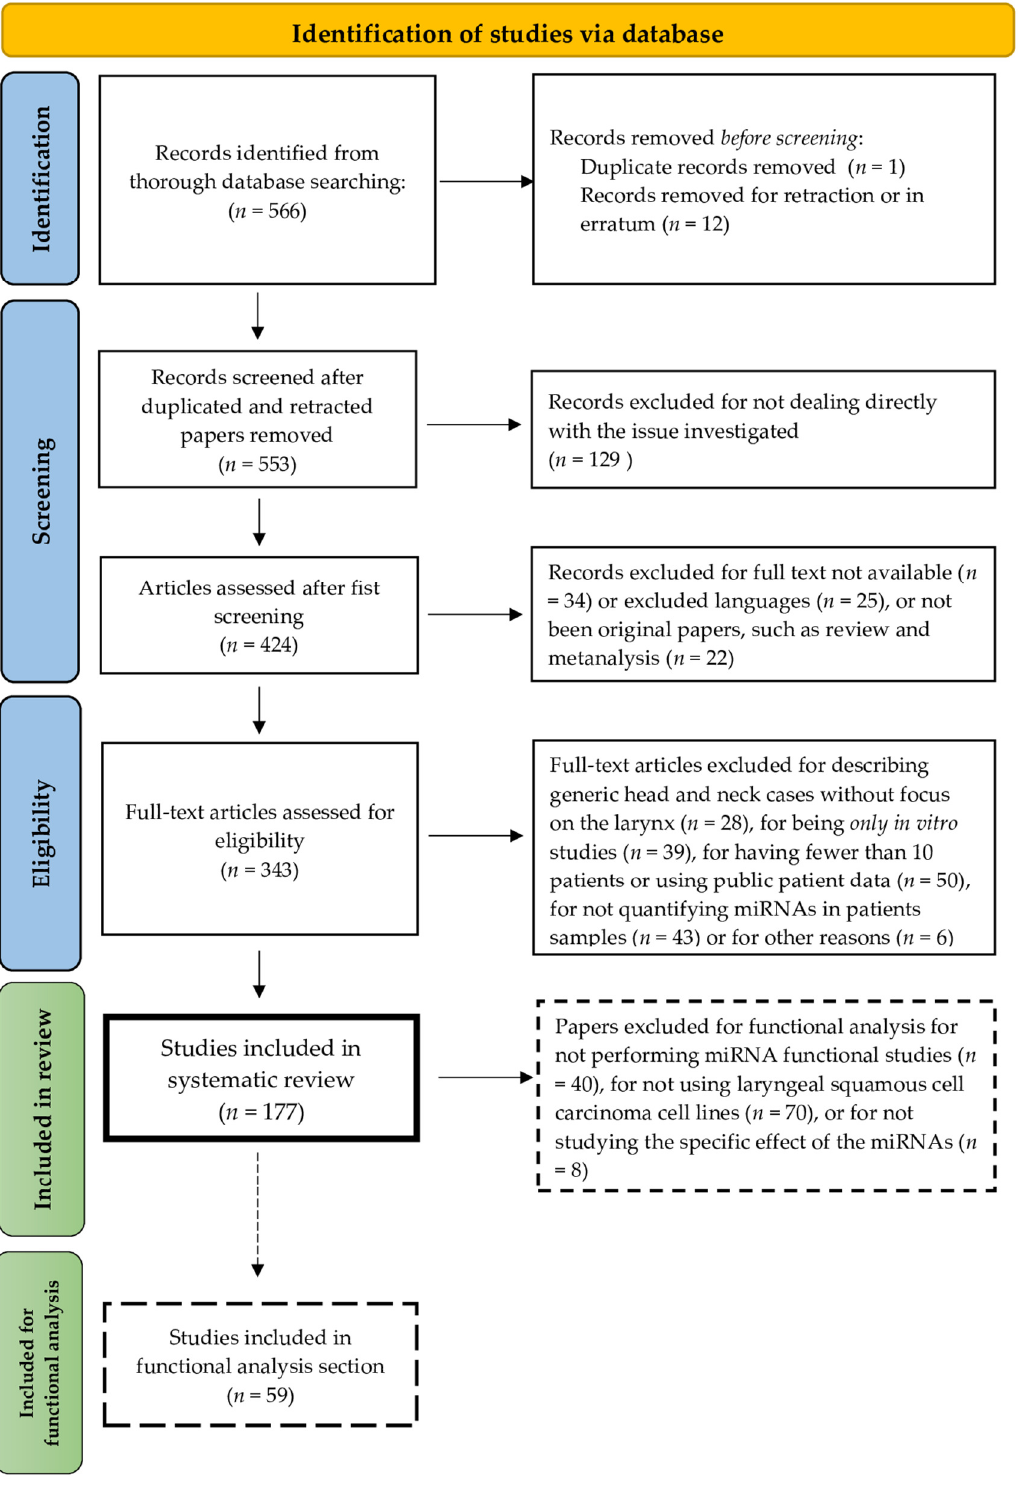
Figure 1. Flow chart showing the steps of the systematic review of the literature. Of 566 papers, 177 original papers were selected in this systematic review. For functional analysis, a further screening was performed and 59 original papers were obtained.